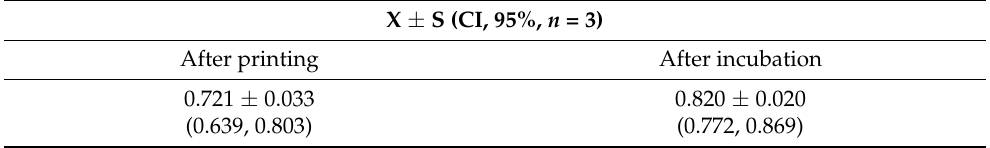
Table 1. Results of measuring the area of objects from 15% GelMA before and after 72 h